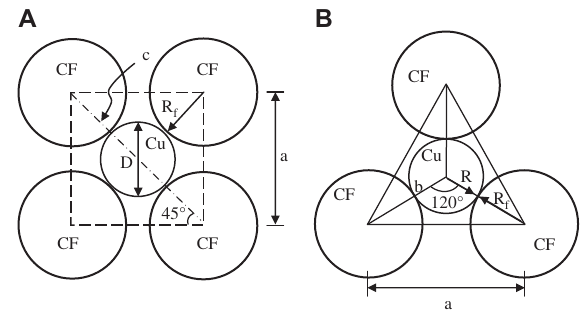
Figure 4 Schemes of theoretical fi ber array [16] with Cu spacer for; (A) square fi ber distribution and (B) hexagonal fi ber distribution.